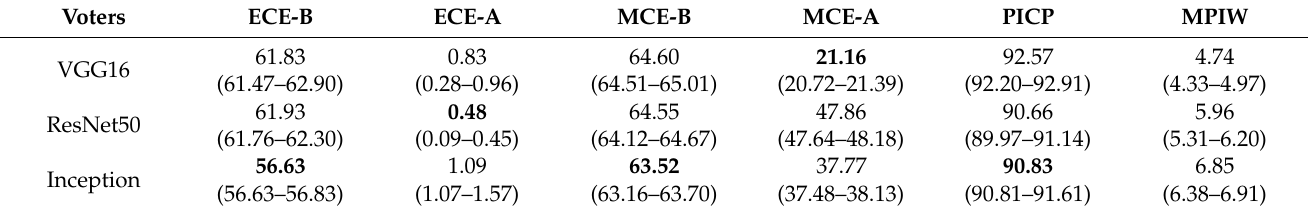
Table 1. Calibration (in %) of voters on unseen